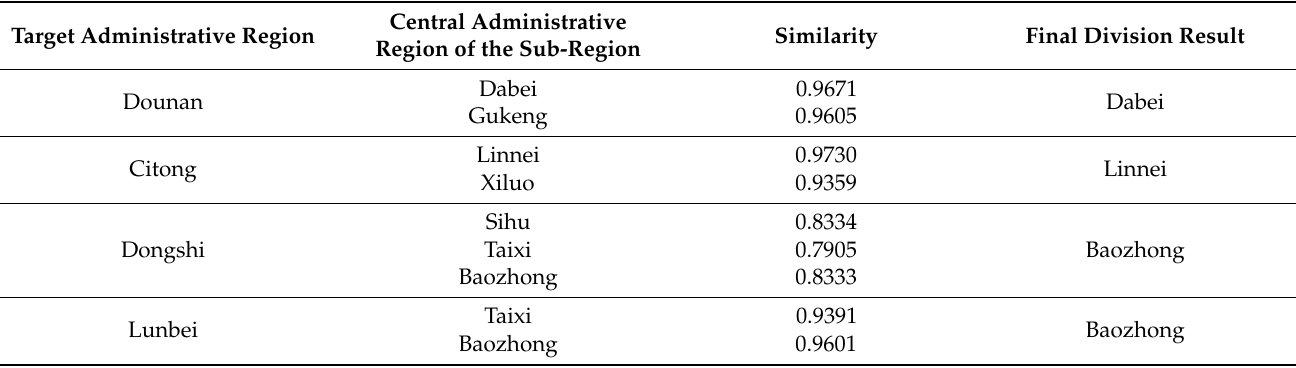
Table 4. Calculation results of similarity between the administrative region for which the sub-region cannot be judged and the central administrative region of other